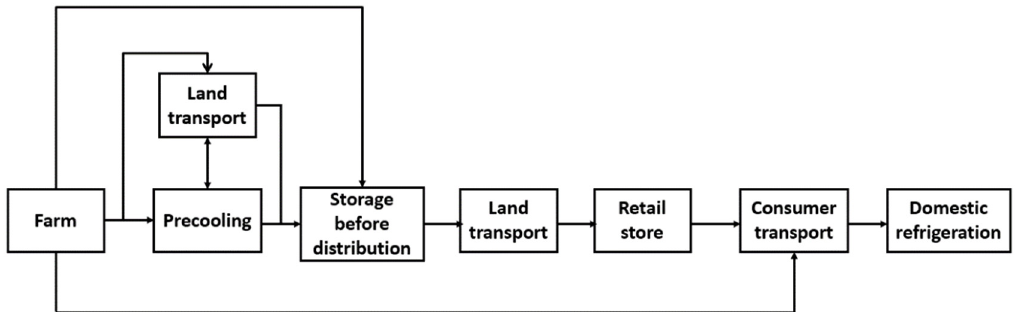
Figure 1. Simplified food cold chain system.